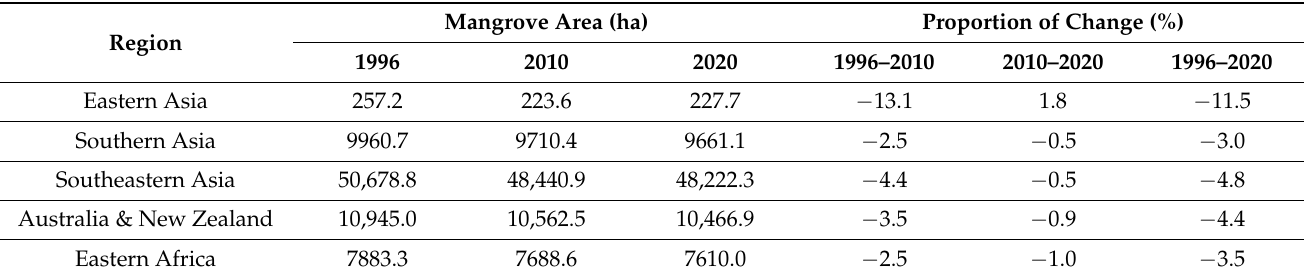
Table 6. Changes in mangrove area by region (Leal & Spalding, [45]).